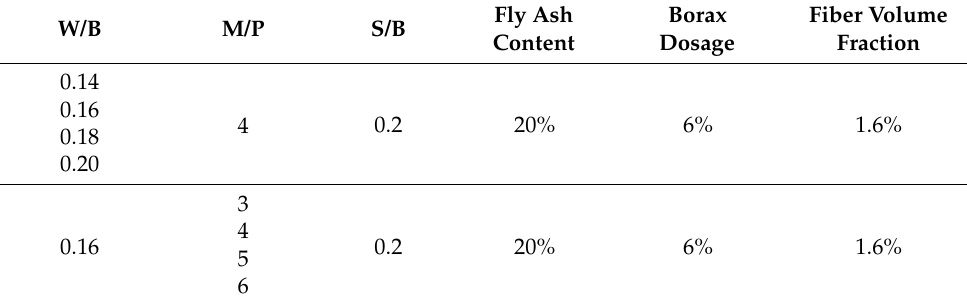
Table 6. Experimental mix